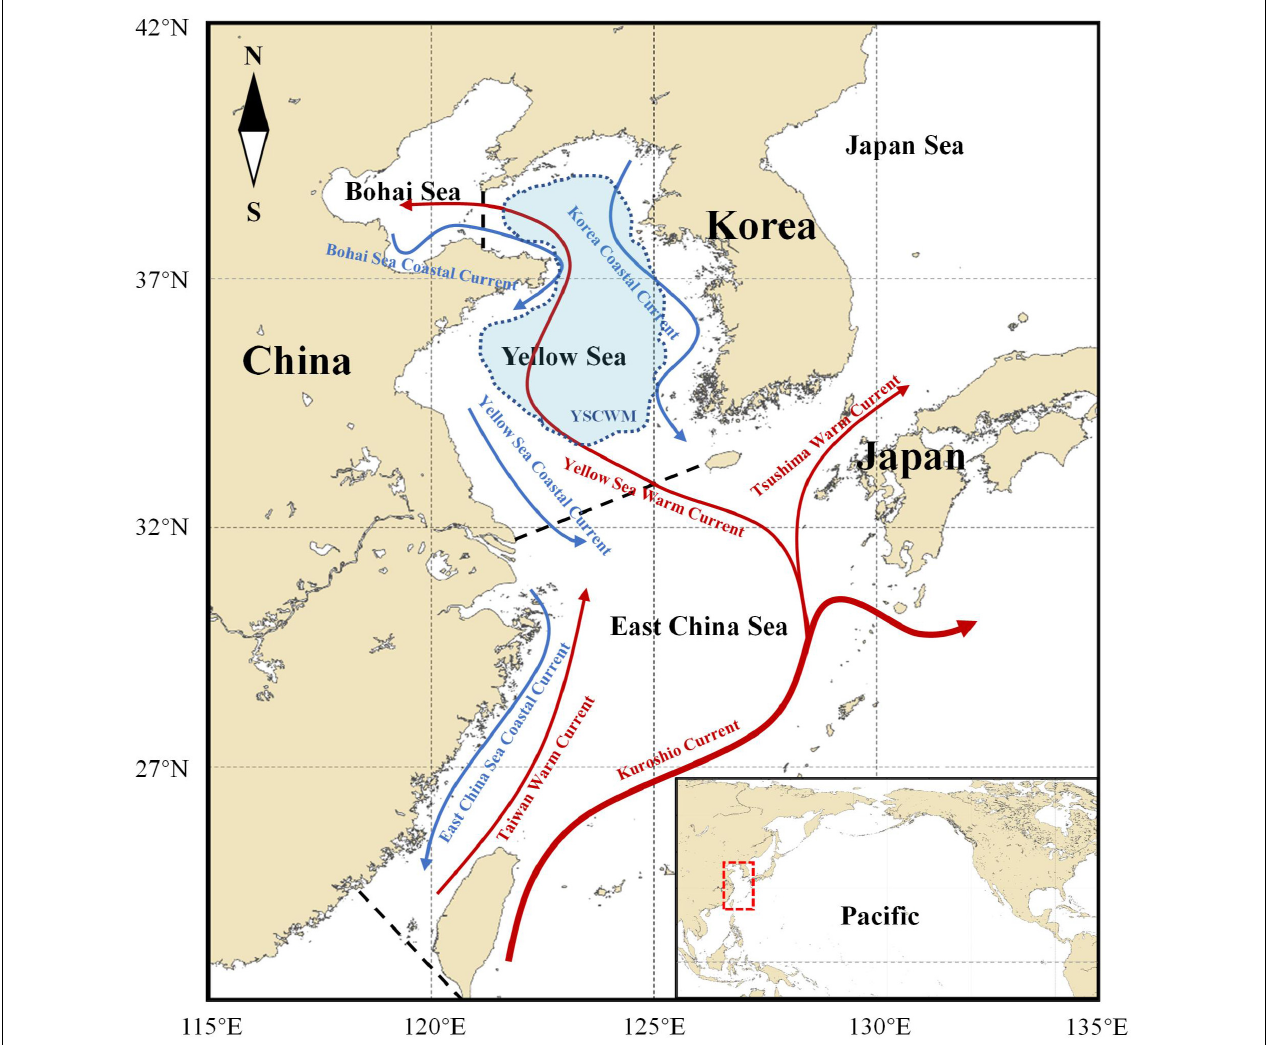
FIGURE 1 | Location of China Seas (Bohai Sea, Yellow Sea, and East China Sea) and the schematic illustration of their currents. Dashed red box in the bottom right corner map shows the China Seas which is in the western margin of the North Pacific. Arrows with solid lines represent the currents. Warm currents: red. Cold currents: blue. Blue shading represents the yellow sea cold water mass (YSCWM). Dashed black lines are boundaries between